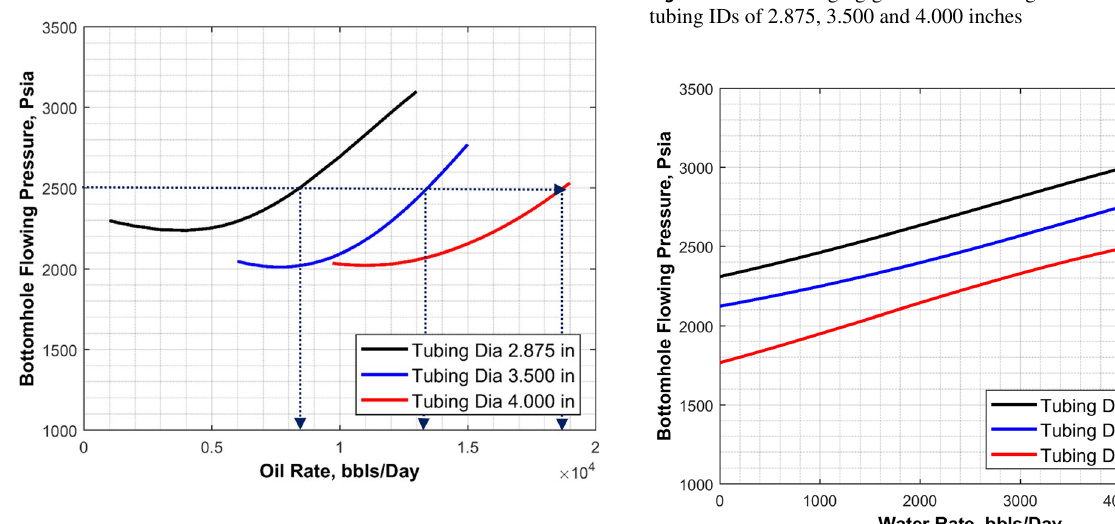
Fig. 8 Effect of changing oil rate on flowing bottom-hole pressure at tubing IDs of 2.875, 3.500 and 4.000 inches